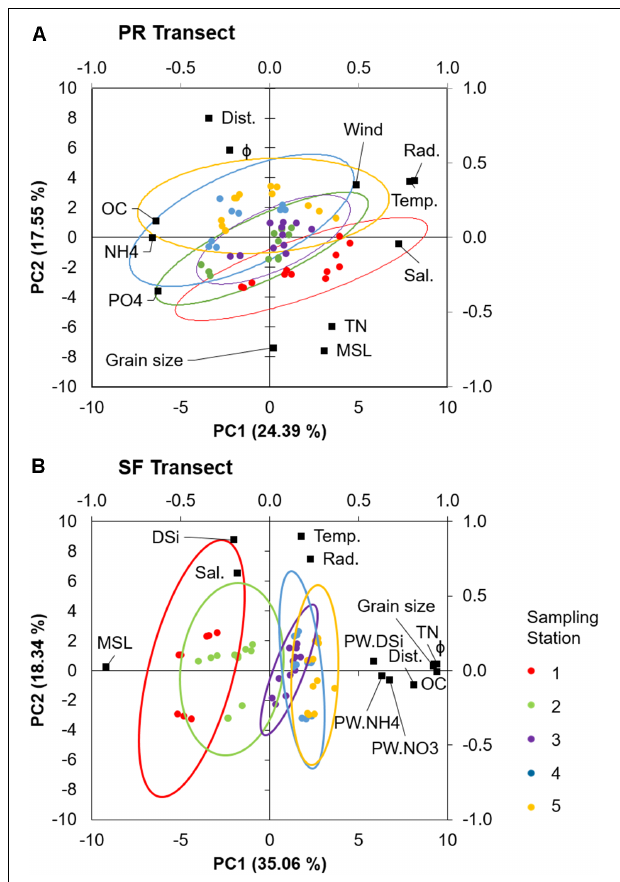
FIGURE 6 | Principal components analysis of environmental variables for the (A) Puerto Real (PR) and (B) San Fernando (SF) transects. Only variables for which the squared cosine is the largest in each axis are shown. Colored symbols represent the five stations sampled at each transect during the four sampling campaigns. The ellipses represent 95% confidence intervals for each